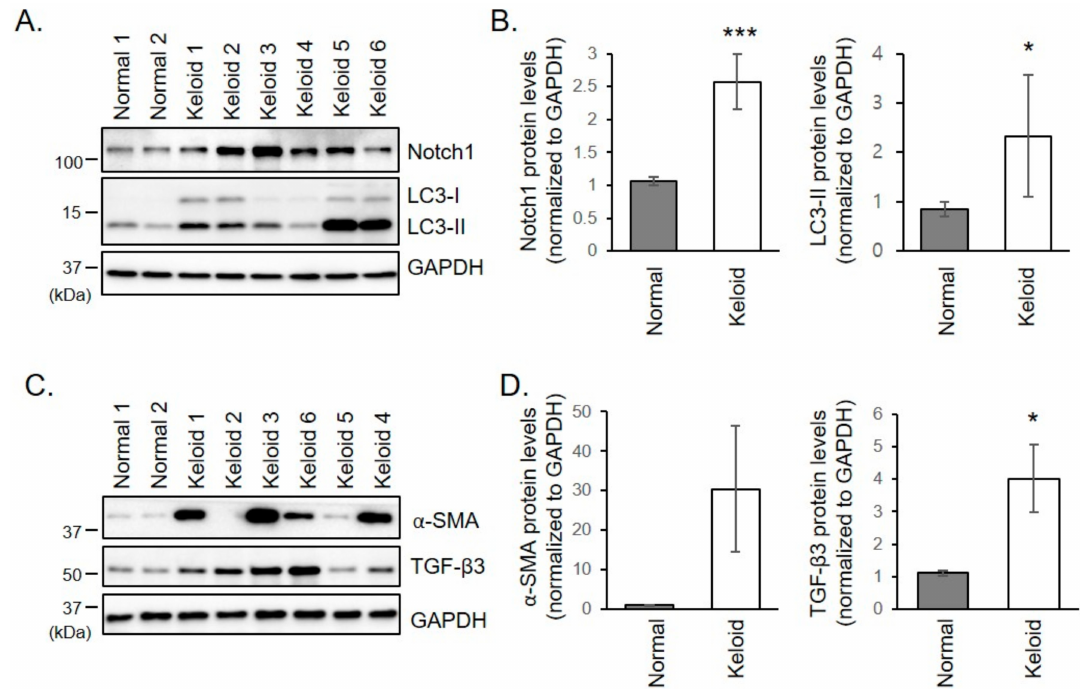
Figure 1. ( A , B ) Increased expression of Notch1 and LC3 in keloid fibroblasts. ( A ) Normal and keloid fibroblasts were subjected to immunoblotting against Notch1 and LC3. Gels are representative of five experiments. ( B ) Graphs represent means ± s.d. * p < 0.05; *** p < 0.001. ( C , D ) Increased expression of α -SMA and TGF- β 3 in keloid fibroblasts. ( C ) Normal and keloid fibroblasts were subjected to immunoblotting against α -SMA and TGF- β 3. Gels are representative of five experiments. ( D ) Graphs represent means ± s.d. * p <